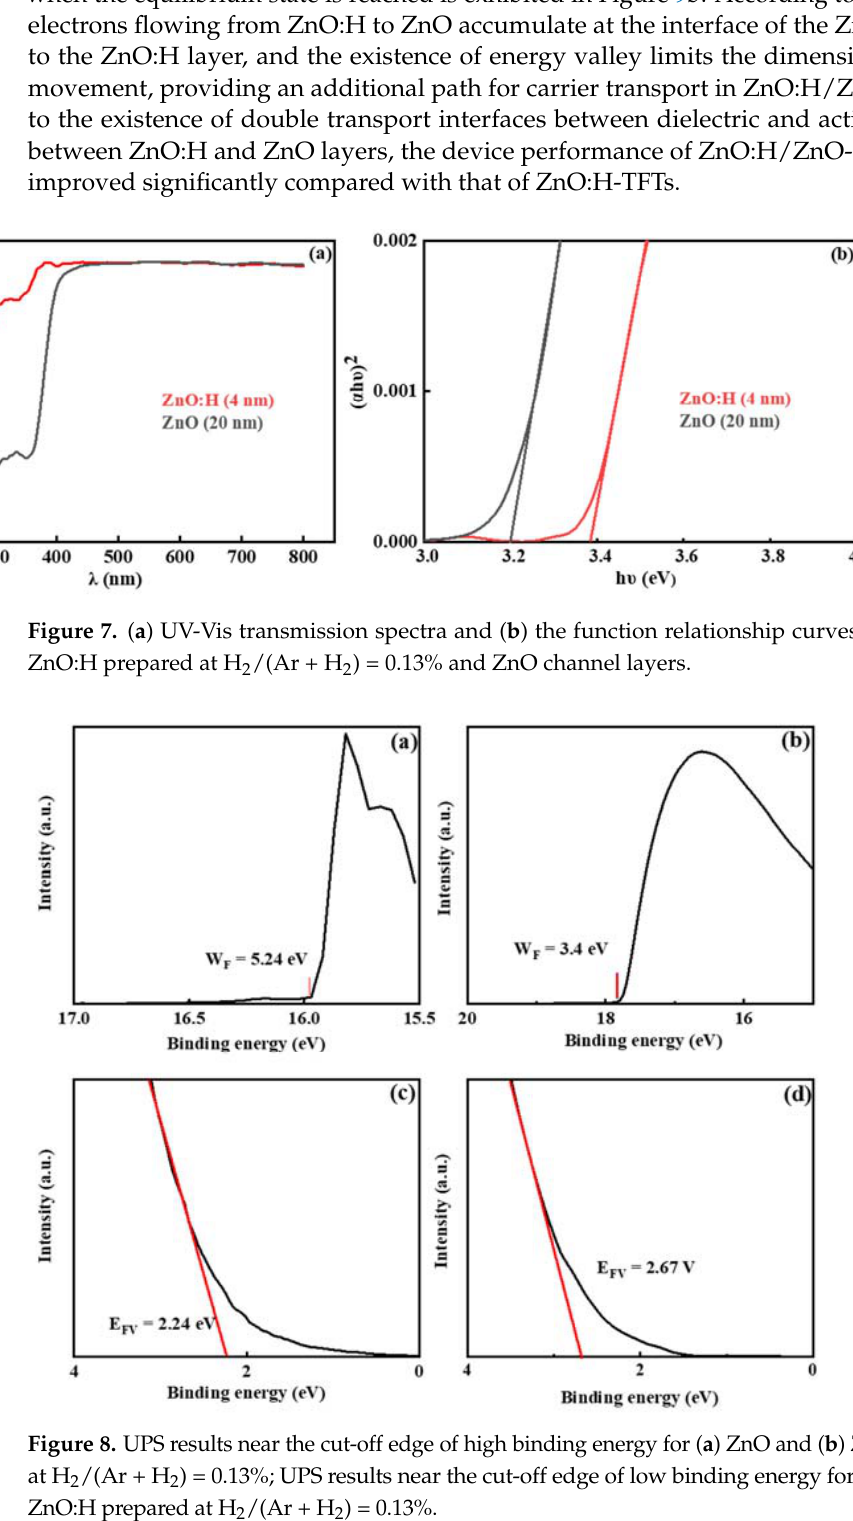
Table 1. The device characteristics of ZnO:H/ZnO ‐ TFTs fabricated with different H 2 /(Ar + H 2 ) and ZnO:H ‐ TFT fabricated at H 2 /(Ar + H 2 ) = 0.10%. H 2 /(Ar + H 2 ) (%) μ sat (cm 2 /Vs)